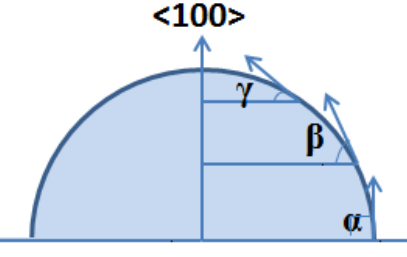
Figure 2. Section of approximate hemisphere.